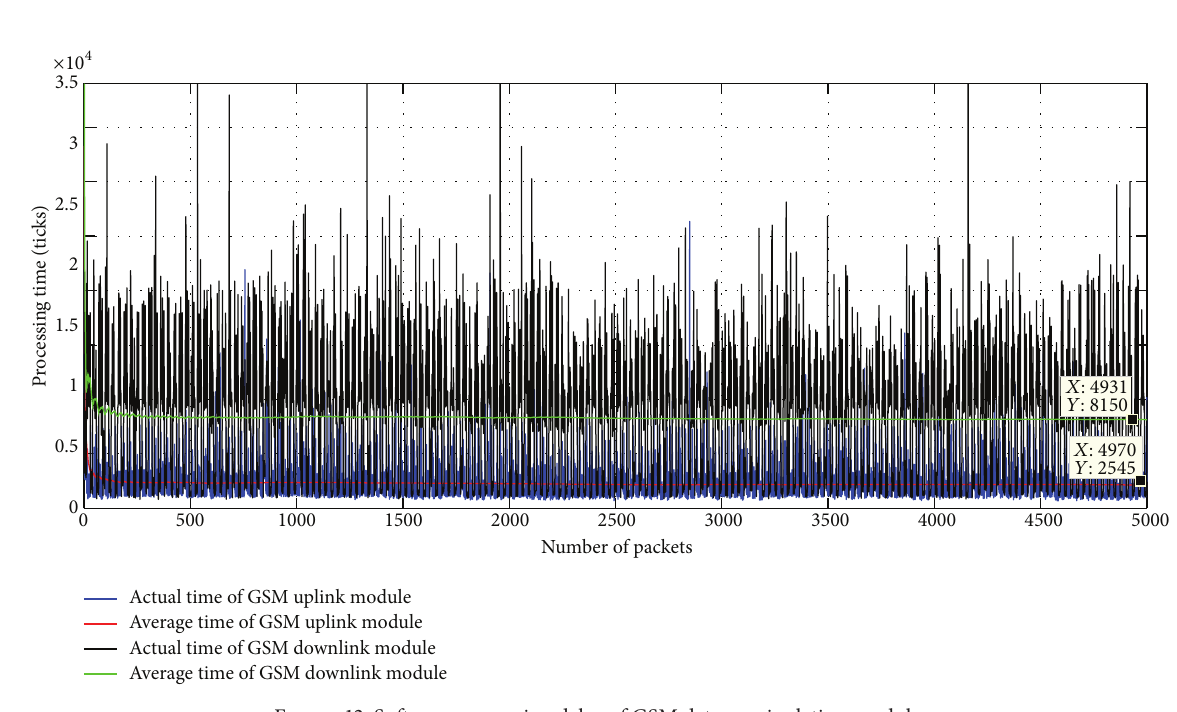
Figure 12: Software processing delay of GSM data manipulation